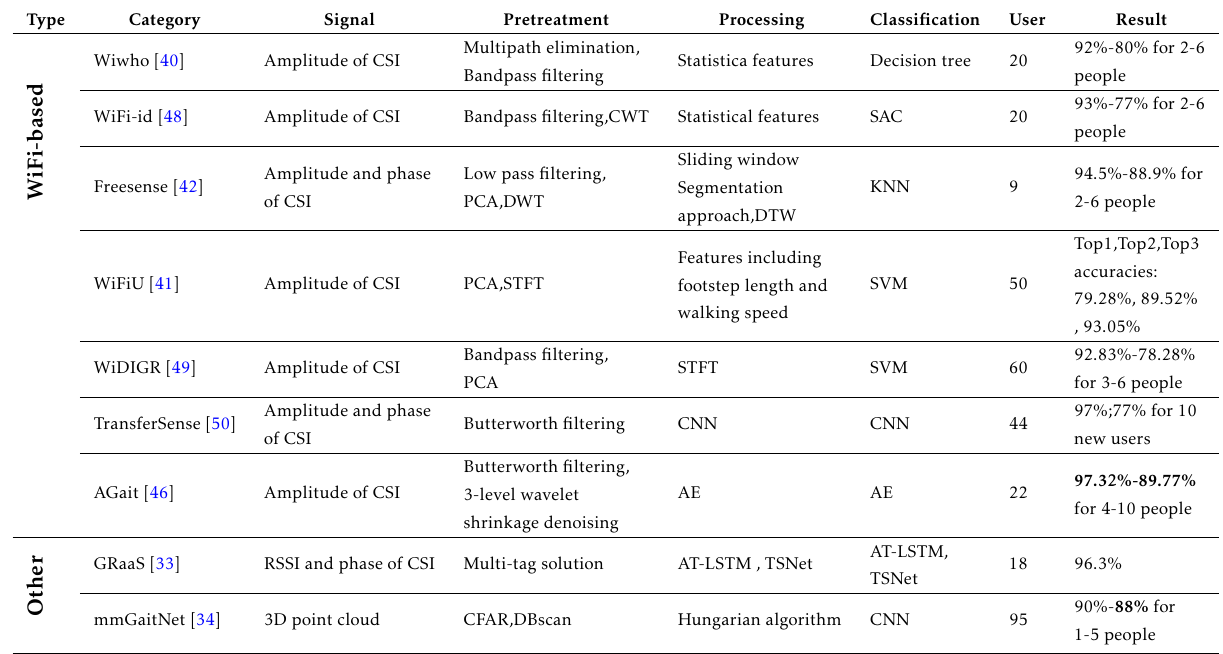
Table 1. METHODS AND RELVENT